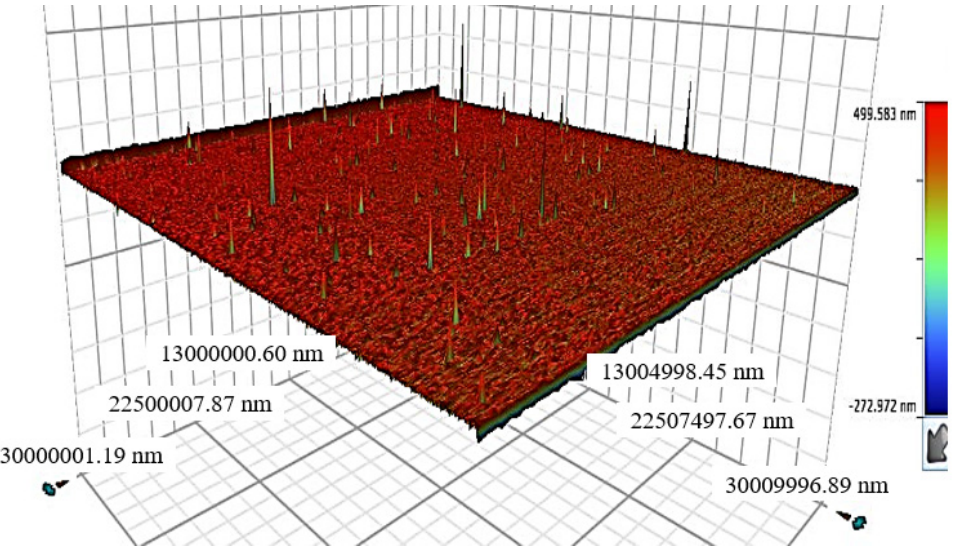
Figure 7. 3D map obtained by the profilometer of the Uncoated-intact samples before the application of the filter.